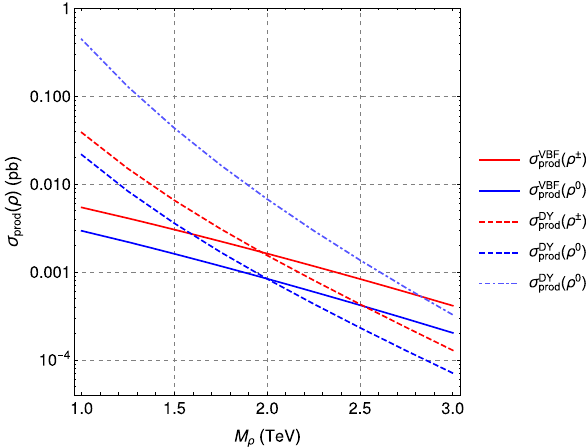
Fig. 7 The production cross sections σ prod ( pp → ρ X ) for the DY and VBF productions of the neutral (blue) and charged (red) vector resonances as functions of the resonance mass when g (cid:2)(cid:2) = 20. The solid lines stand for the VBF production which is insensitive to the direct interactions. The dashed lines denote the DY production without the direct interactions. The dot-dashed line shows the neutral DY case with the direct interactions, namely b L = b R = 0 . 1, p =